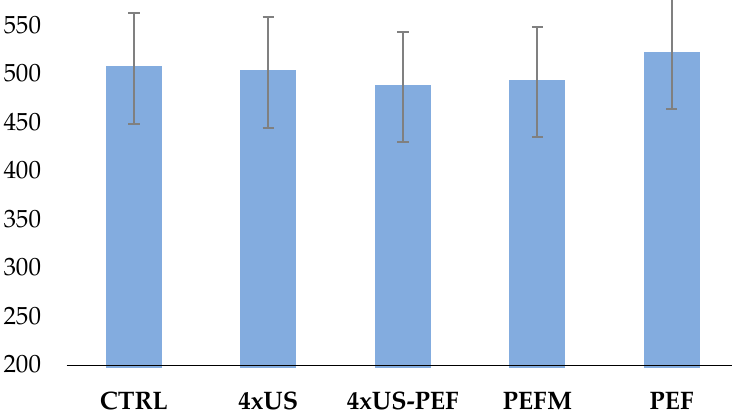
Figure 8. Total polyphenol contents in oil samples obtained from half-ripe Coratina olives according to the processing technology (mg/kg) (mean ± U, which represents the expanded measurement uncertainty with a coverage factor k = 2 and a confidence level of 95%. Results from INNOVHUB laboratory).